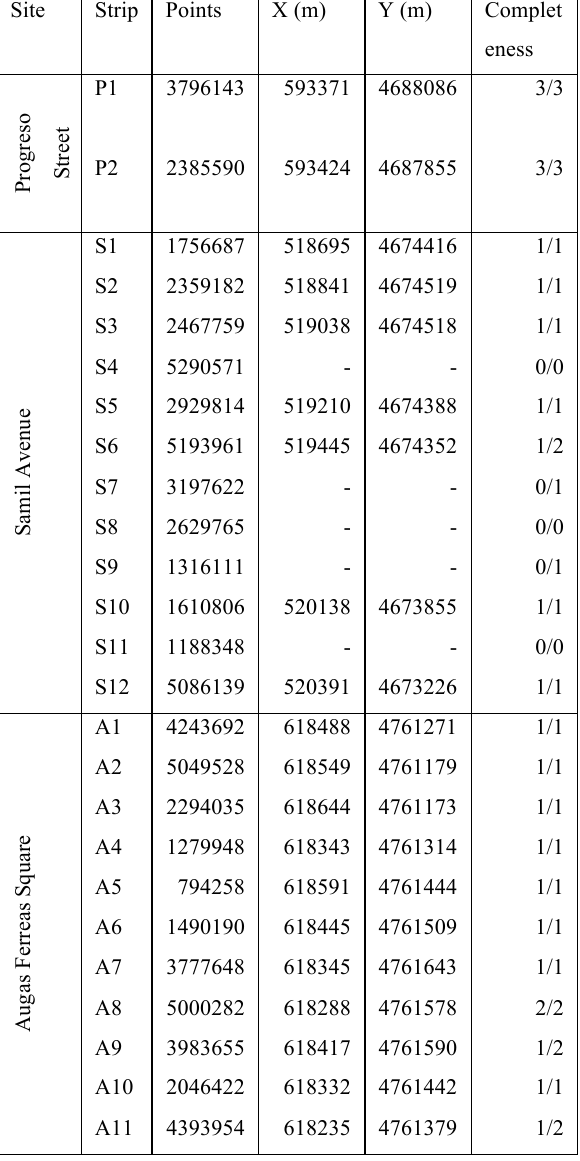
Table 1. Results found for the three study sites.